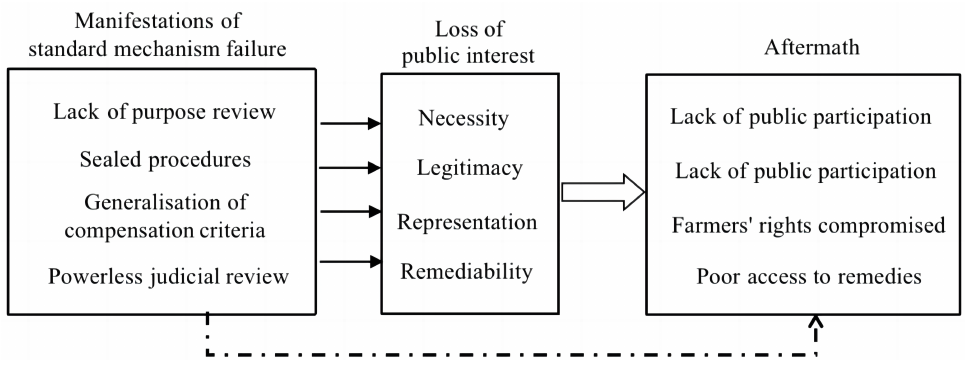
Figure 1. New risks arising from the failure of levy standards for tract